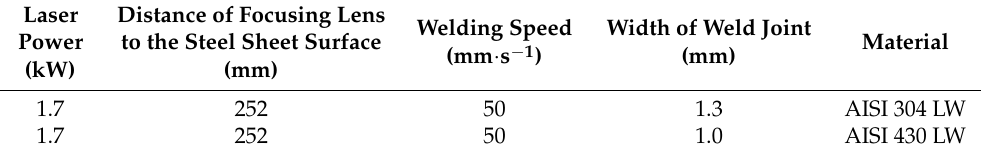
Table 3. Laser welding parameters.